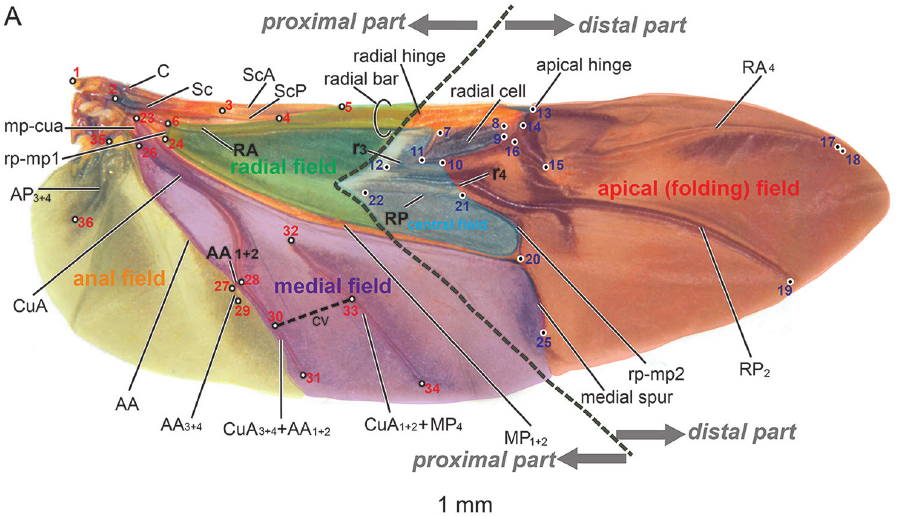
Figure 1. Leaf beetle hind wing ( Chrysomela populi Linnaeus), with landmark locations (the dot with number), vein nomenclature and regional division. The nomenclature of the wing venation follows that of Kukalová-Peck & Lawrence (1993, 2004). Radial area: green, central area: blue, medial area: purple, anal area: yellow, apical (folding) area: red. Proximal part landmarks 1–6, 23, 24, and 26–36 mainly include radial, medial, and anal areas; distal part landmarks 7–22 and 25 include the central area, radial cell, and apical area. Abbreviations: Costa (C), Subcosta (Sc), Subcosta Anterior (ScA), Subcosta Posterior (ScP), Radius Anterior (RA), Radius Posterior (RP), Radial cross veins (r3, r4), Media Posterior (MP), Radio- medial cross veins (rp-mp1, rp-mp2), medial cross vein (cv), Cubitus Anterior (CuA), Medio-cubital Cross-vein or Arculus (mp-cua), Anal Anterior (AA), Anal posterior (AP). “+” indicates fused veins. The sub-number of veins reflects vein